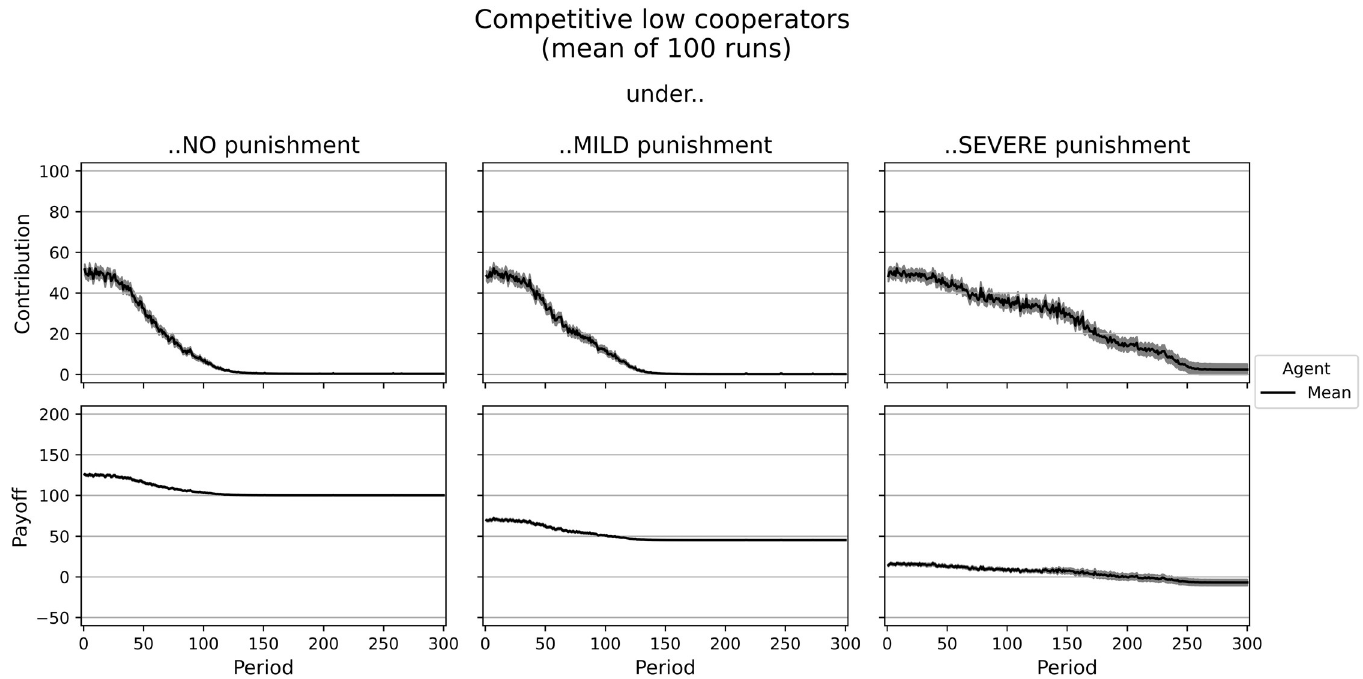
Fig 5. Dynamics of contributions and payoffs of competitive low cooperators under no, mild, and severe punishment. Arithmetic mean of 100 simulation runs. In gray: confidence interval (95%) around the mean.